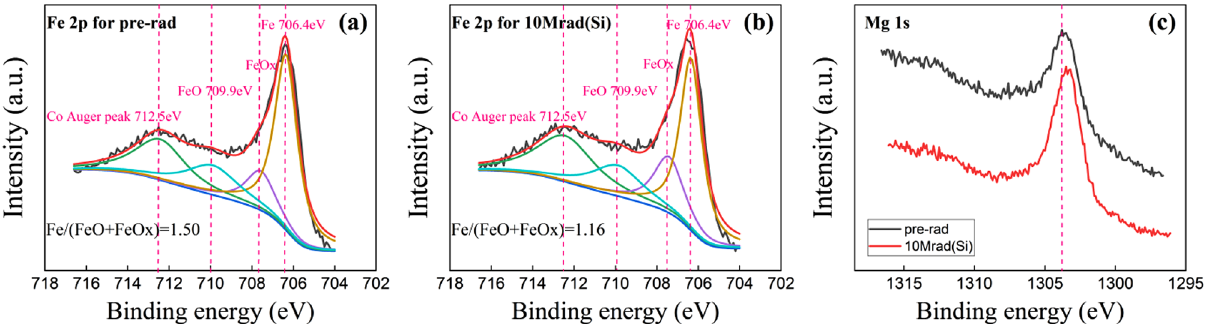
Figure 6. ( a ) Fe 2p XPS spectrum before X-ray radiation, ( b ) Fe 2p XPS spectrum after radiation with 10 Mrad(Si) total ionizing dose, and ( c ) Mg 1 s XPS spectra without radiation and with 10 Mrad(Si) radiation. All above XPS spectra are detected from the MgO/CoFeB interface in the Ta/MgO/CoFeB/Ta